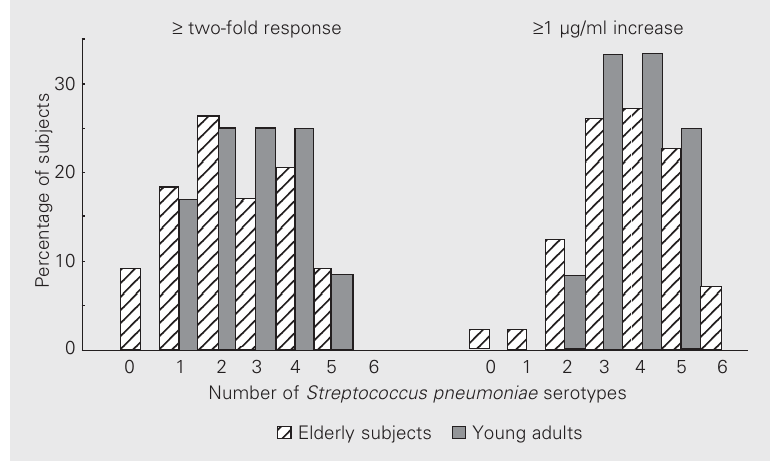
Figure 2. Immune response after pneumococcal vaccination reported as a two-fold in- crease or increase of 1 µg/ml or more of polysaccharide-specific IgG against the indicated number of serotypes. No significant differences were detected between elderly and young adults (P > 0.05, chi-square